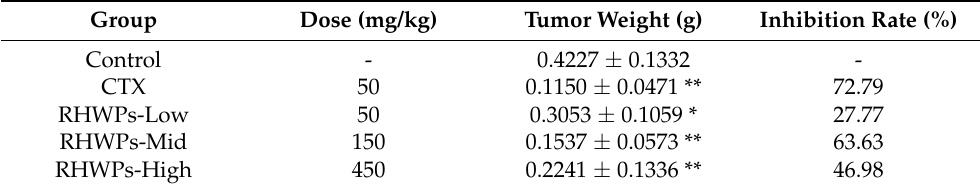
Table 6. Inhibition of S180 tumors by RHWPs (significant differences from the control groups are designated as * p < 0.05 and ** p < 0.01 ( n = 10)).